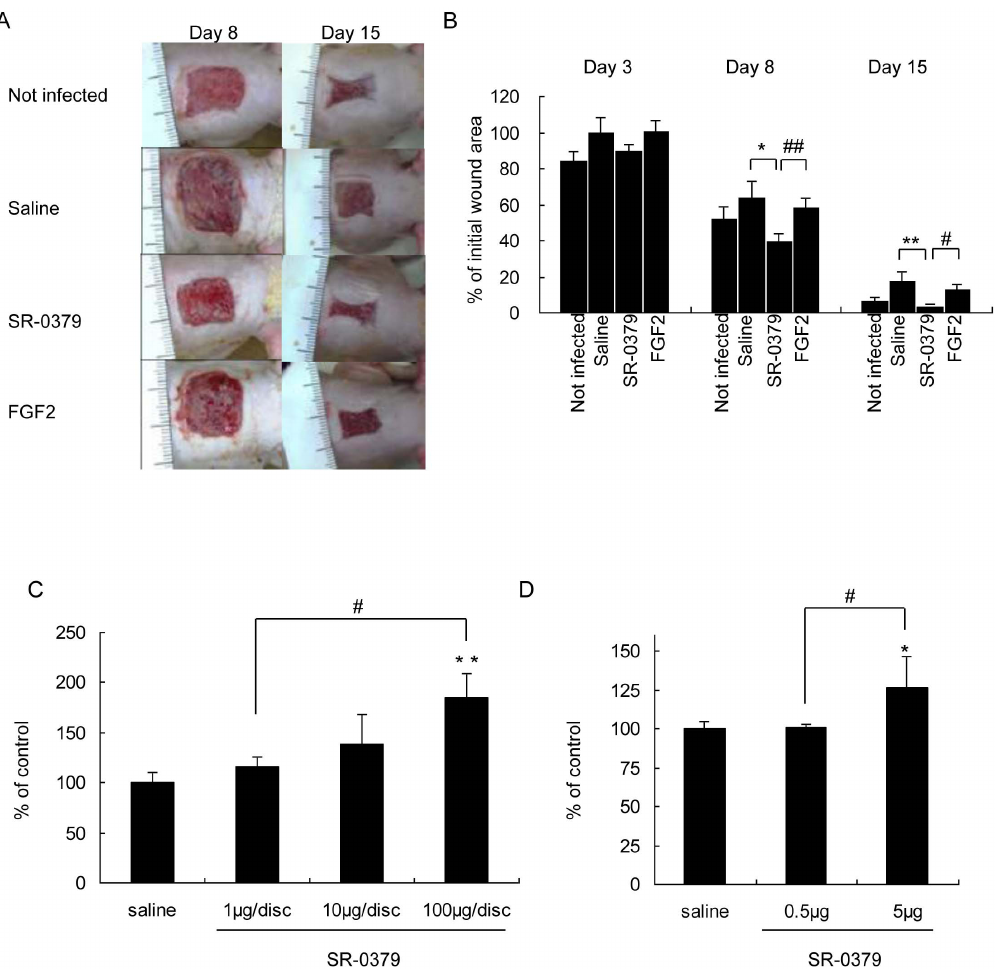
Figure 5. Effects of SR-0379 and FGF2 on the full-thickness skin infected wound model. A) Representative pictures of full-thickness skin flaps in uninfected, saline (control), SR-0379 (1 mg/ml) and FGF2 groups (0.125 mg/ml) on days 8 and 15. B) Quantification of the infected wound area is represented as a percentage of the initial wound area. N=5 per group. **P , 0.01 vs. control, ## P , 0.01 vs. FGF2. C) Effects of SR-0379 (1, 10 and 100 m g/disc) on the healing of paper disc implantation in rats. N=4-5 per group. **P , 0.01 vs. control, # P , 0.05 vs. 1 m g/disc. D) Effects of SR- 0379 (0.5 and 5 m g) on the healing of an experimental open wound in rats. N=3-4 per group. *P , 0.05 vs. control, # P , 0.05 vs. 0.5 m g.